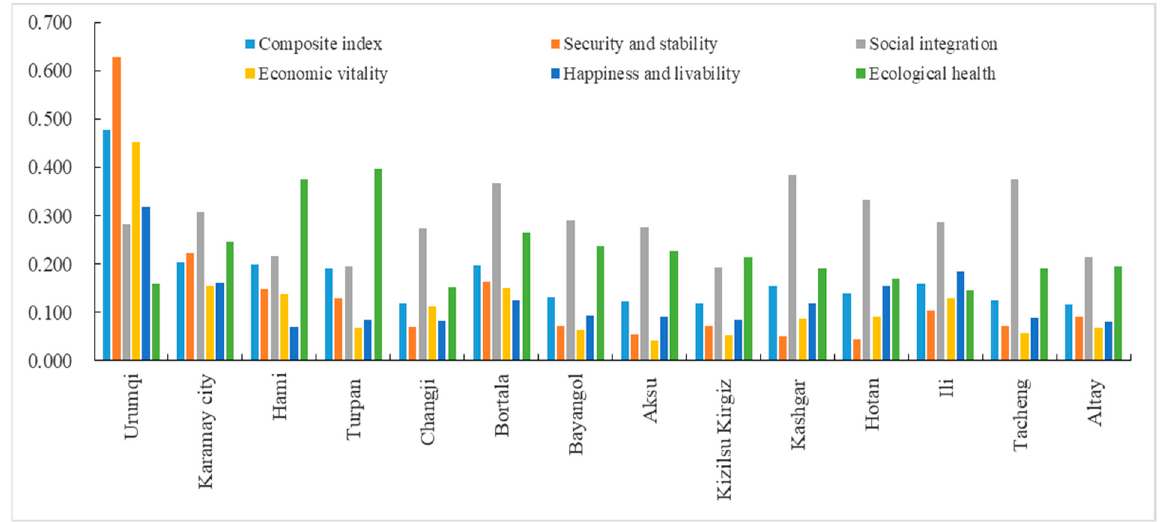
Figure 4. Composite index and sub-dimension index of urbanization sustainability in Xinjiang.